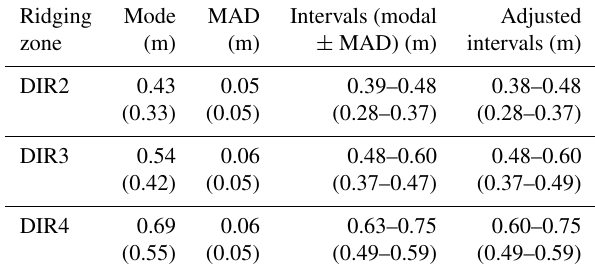
Table 2. Estimated mode, mean absolute deviation (MAD), and in- tervals (thresholds) from 95th percentile (5% highest values) of the elevation anomalies, h a , for each DIR zone. The thresholds are given by the modal value ± MAD. Adjusted intervals are simply to exclude the gap between DIR3 and DIR4. Values in parentheses show the 98th percentile of elevations subtracting the mean rather than the elevation anomaly h a , which could potentially be useful for excluding possible noise measurements. The 98th-percentile ap- proach is discussed further in Sect. 3.3.